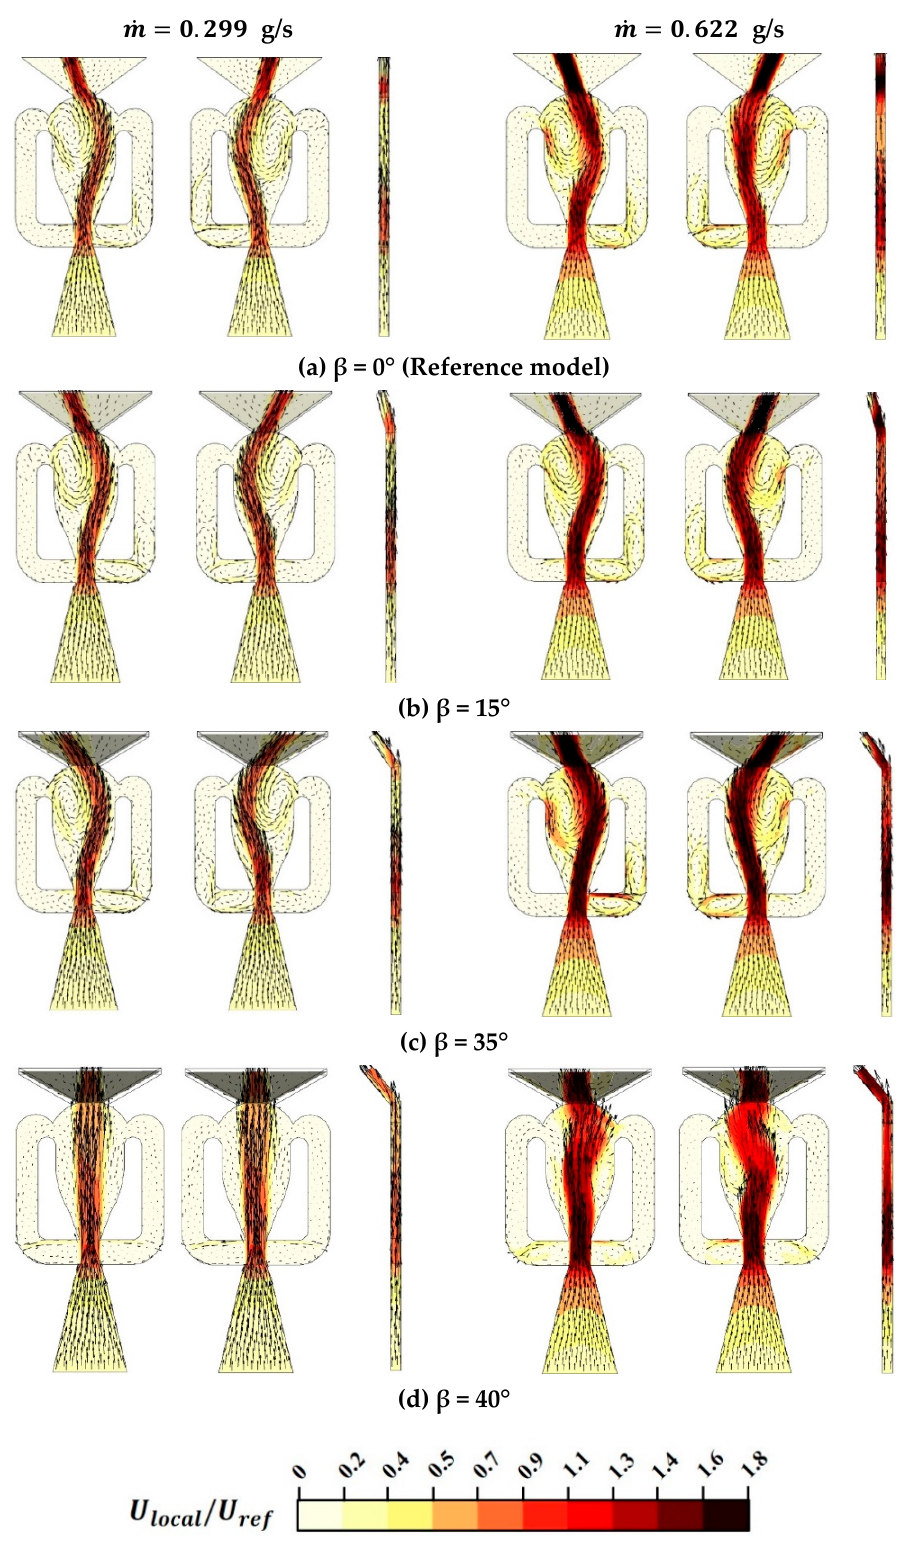
Figure 12. Velocity contours and vectors for different bending angles and flow rates (Left: Φ = 90° , Center: Φ = 270° , Right: x-z cross section).